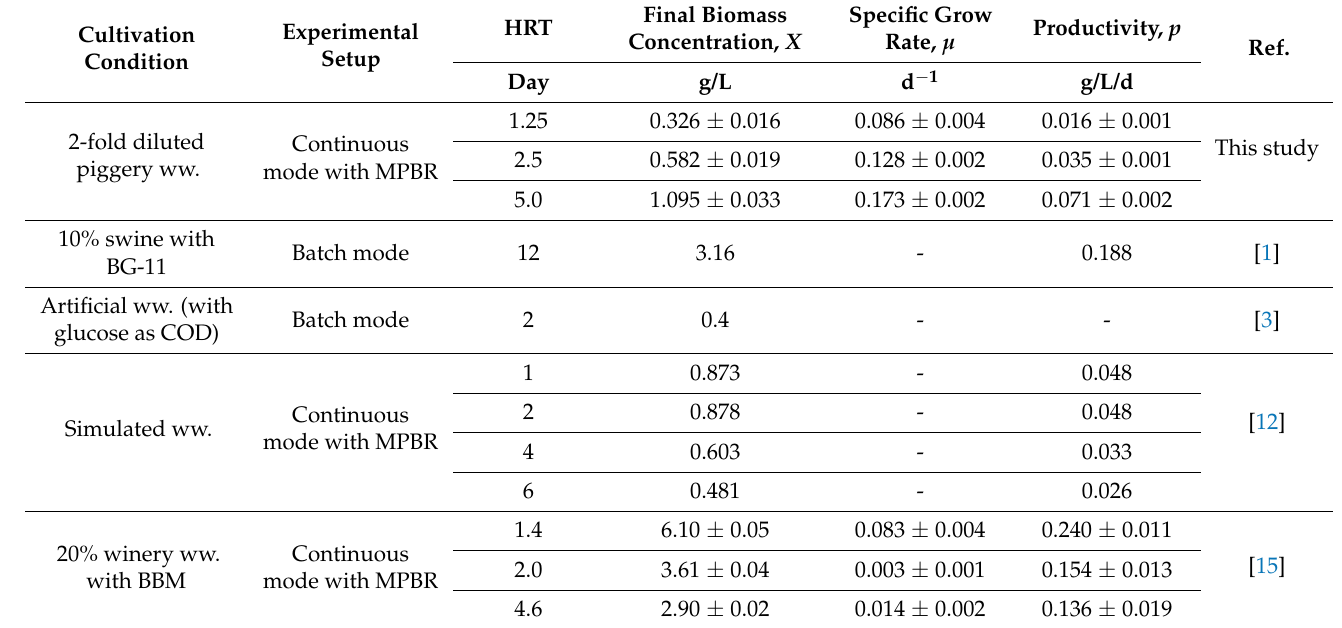
Table 2. Growth characteristic of Chlorella vulgaris in pilot-scaled MPBR with piggery wastewater at three hydraulic retention times in comparison with previous studies.